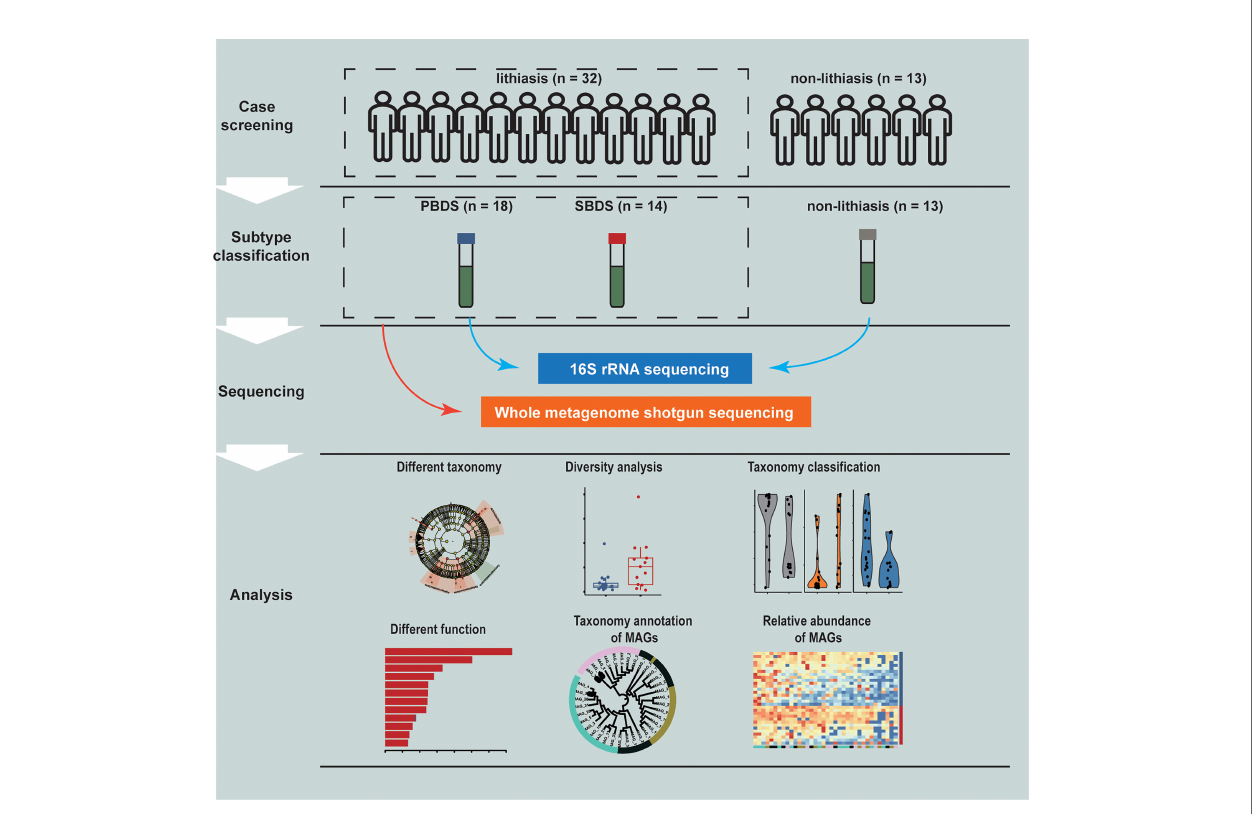
FIGURE 1 | Study design. A total of 45 samples were collected and analyzed through 16S rRNA and wMGS sequencing to explore the differences of biliary microbiota in PBDS, SBDS, and non-lithiasis groups. wMGS, whole metagenomic shotgun sequencing; PBDS, primary bile duct stone; SBDS, secondary bile duct